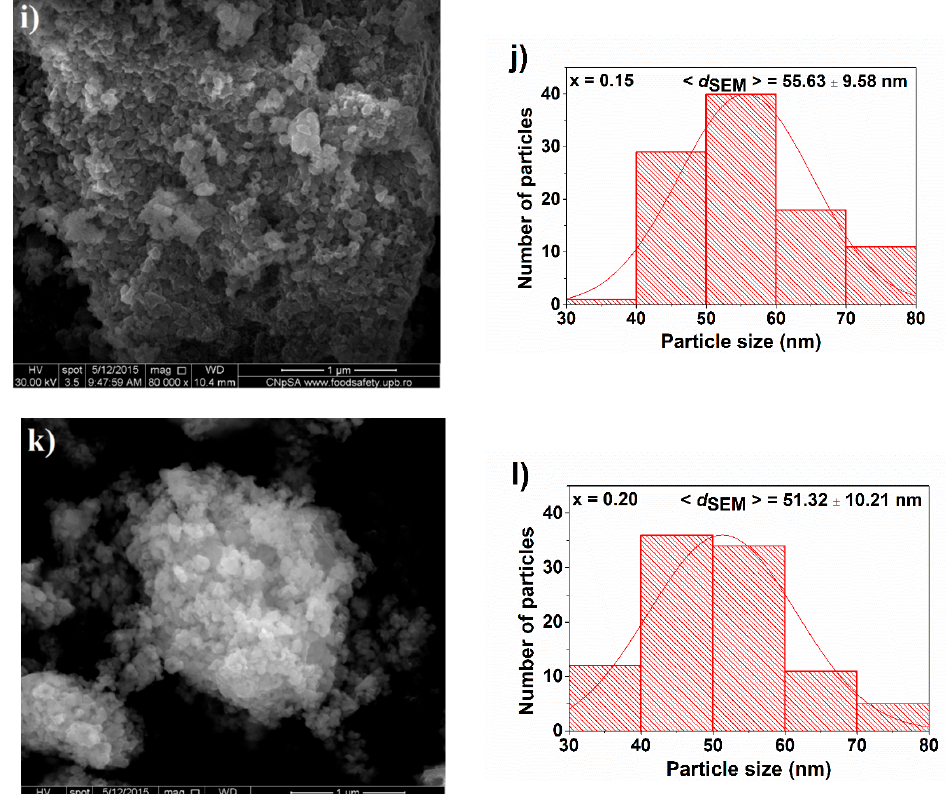
Figure 8. FE-SEM images showing the morphology and corresponding histograms for particle size distribution of Bi 1 − x Eu x FeO 3 powders: ( a , b ) General view for x = 0 and x = 0.10, ( c , d ) x = 0: ( c ) detail, ( d ) particle size distribution, ( e , f ) x = 0.05: ( e ) detail, ( f ) particle size distribution, ( g , h ) x = 0.10: ( g ) detail, ( h ) particle size distribution, ( i , j ) x = 0.15: ( i ) detail, ( j ) particle size distribution, ( k , l ) x = 0.20: ( k ) detail, ( l ) particle size distribution,.